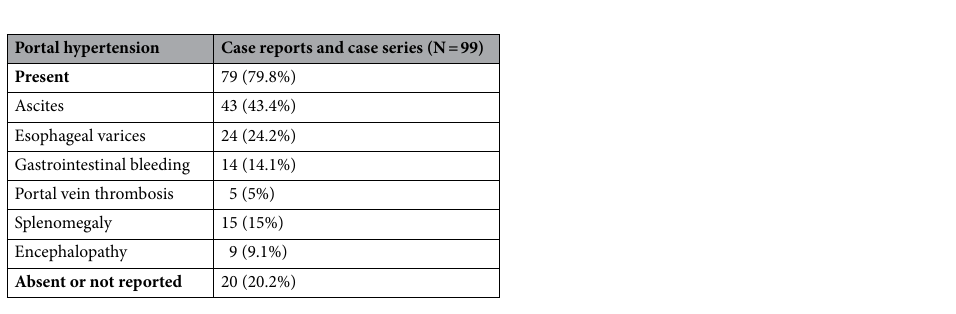
Table 6. Clinical manifestations of portal hypertension reported in case reports/case series and observational study.